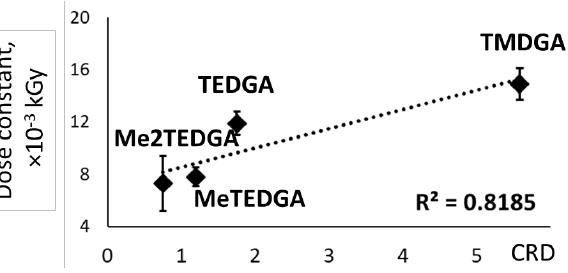
Figure 3. Correlation between the experimental radiolysis constants and the calculated CRD values.